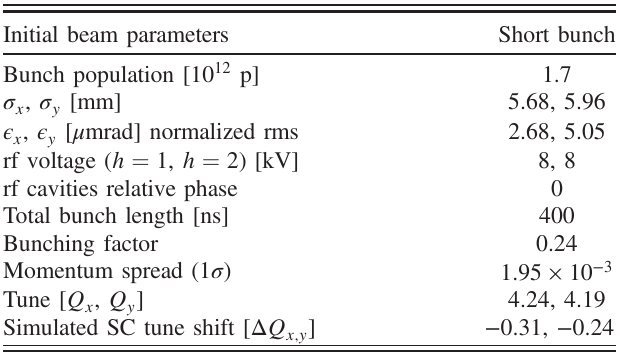
TABLE III. Measured initial parameters for the dynamic integer case.